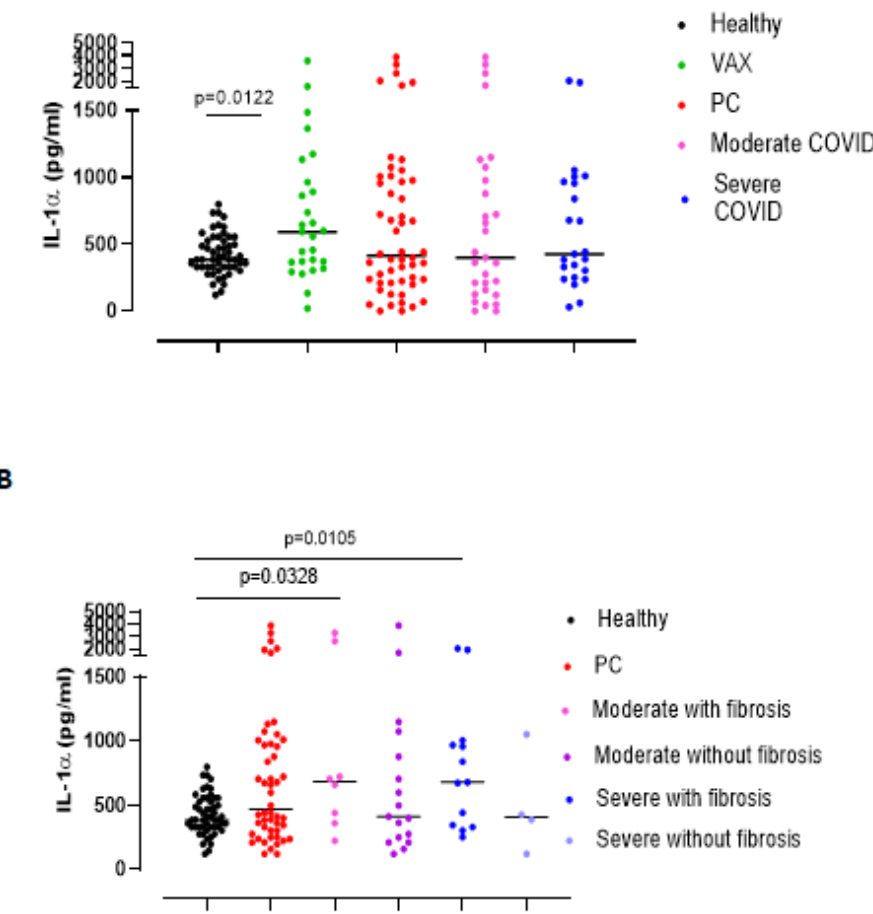
Figure 5. Plasma levels of IL-1 α were increased in PC patients who developed symptoms and signs of pulmonary fibrosis, independently of the grade disease. ( A ) Circulating levels of IL-1 α were not altered in the healthy and PC patients. ( B ) IL-1 α levels were evaluated according to the establishment of lung fibrosis symptoms (moderate or severe PC patients with or without fibrosis, pink or blue dots and purple and bright blue dots, respectively). Data are expressed as median. Statistical analysis was performed according to Mann Whitney U test.